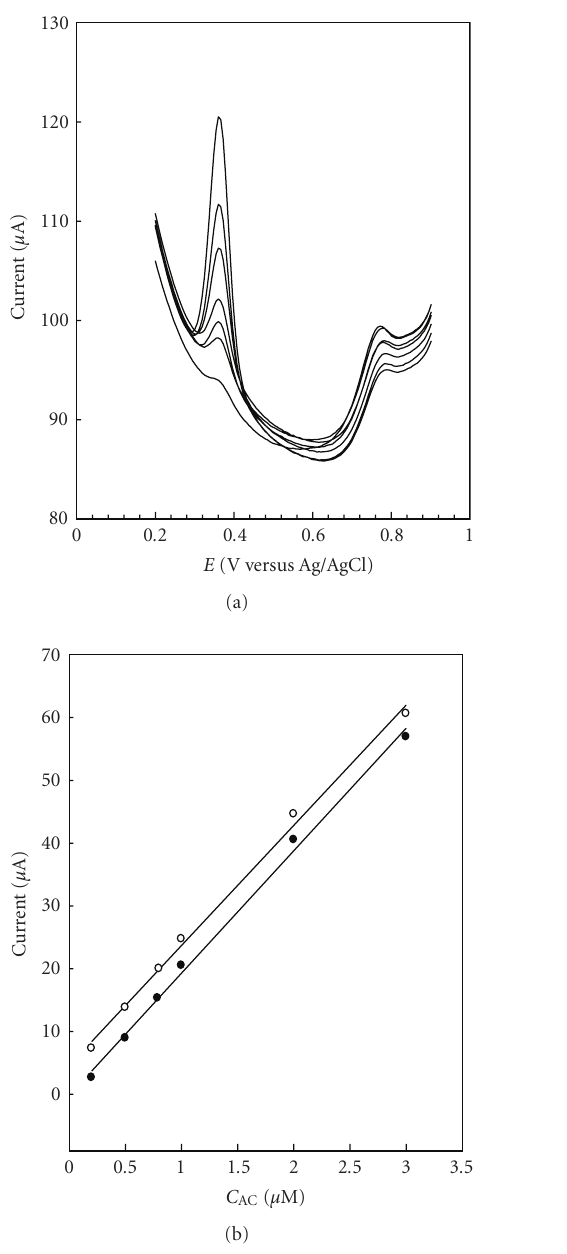
Figure 8: (a) Di ff erential pulse voltammograms of 0.1 M phosphate bu ff er solution containing various concentrations of AC (down to up); 0.2, 0.5, 0.8, 1, 2, 3, 5 μ M AC in the presence of 1 × 10 − 4 M codeine. (b) Linear calibration curve of the anodic peak current versus AC concentration added to ( • ) 0.1 M phosphate bu ff er solution of pH 7.0 and constant amount of codeine, ( ◦ ) AC tablet solution bu ff ered in same pH.